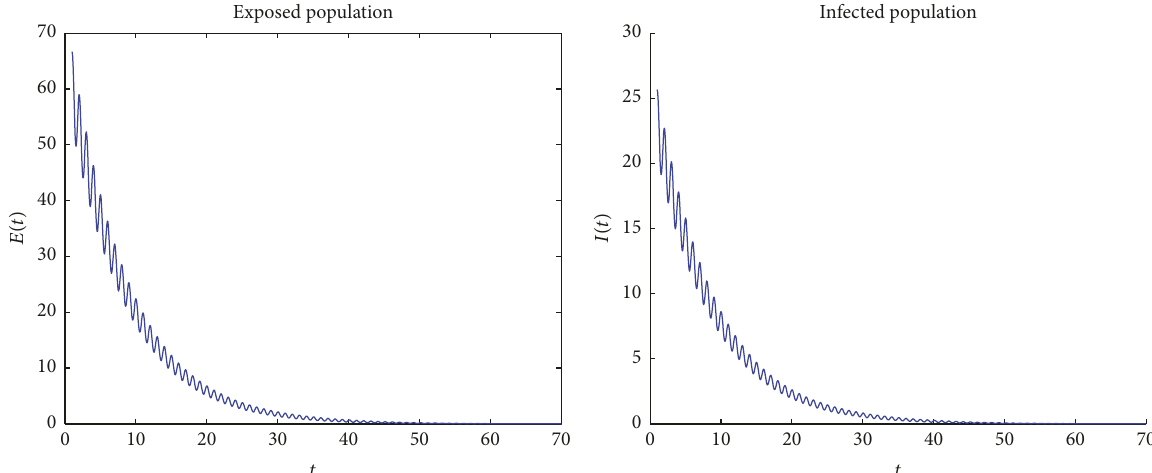
Figure 2: Solution of exposed and infected populations of SEIRS system when R 0 < 1 . We can see that both approach zero when time goes to infinity. Time 𝑡 is given in years.